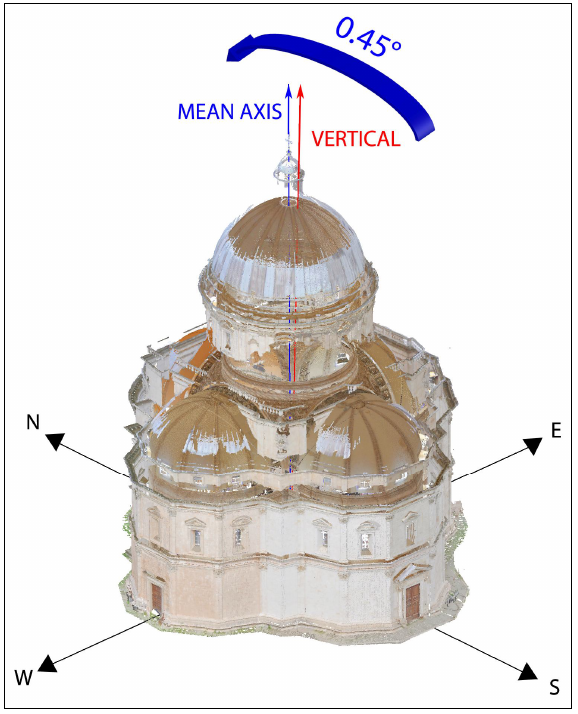
Figure 13. Overall rotation of the